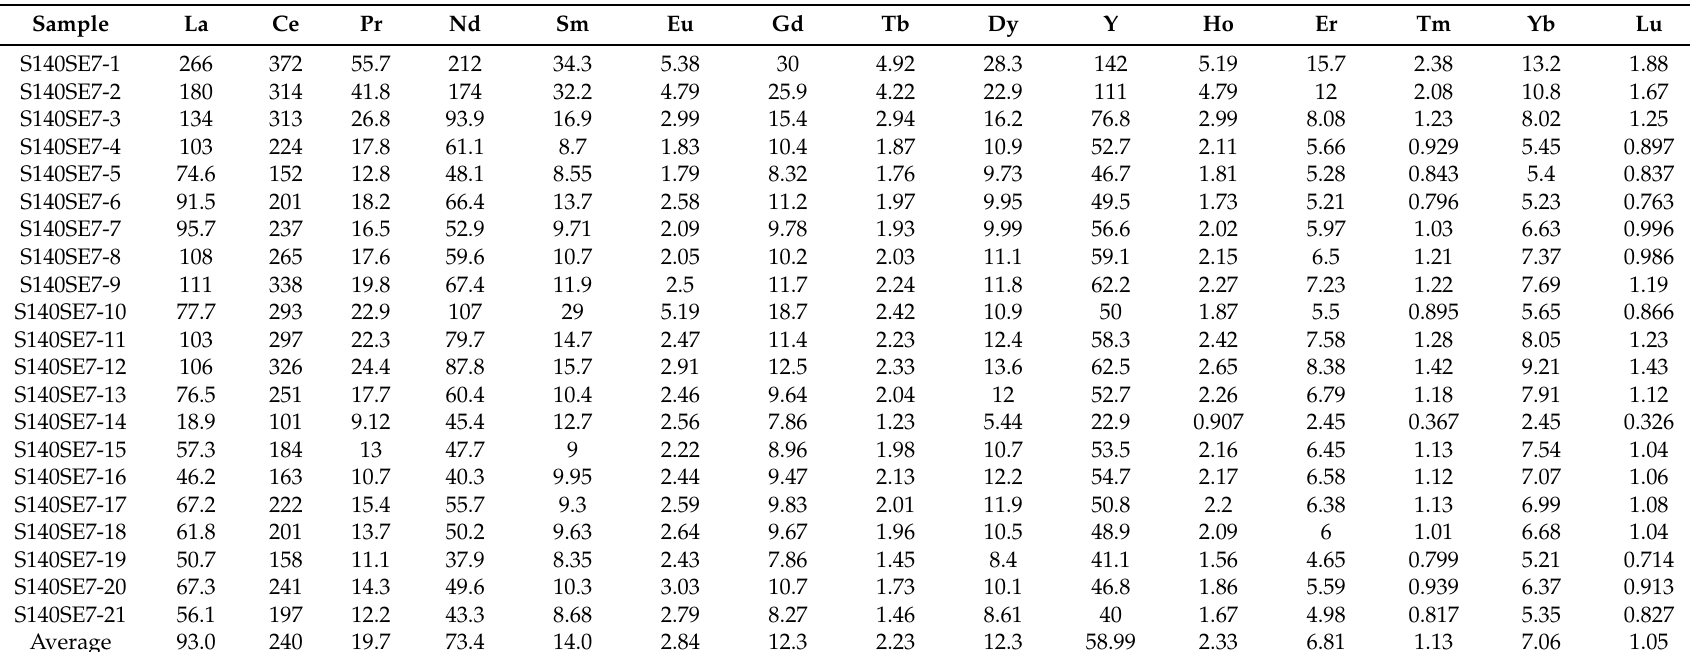
Table 3. Rare earth elements in the tuff samples collected from the Zhongliangshan Mine ( µ